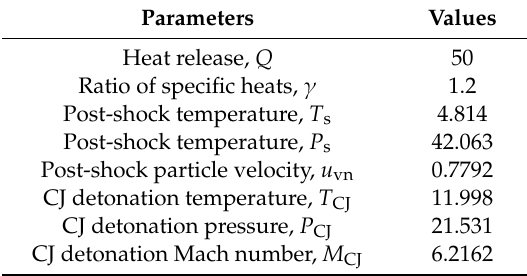
Table 1. Mixture parameters and corresponding Chapman-Jouguet (CJ) detonation